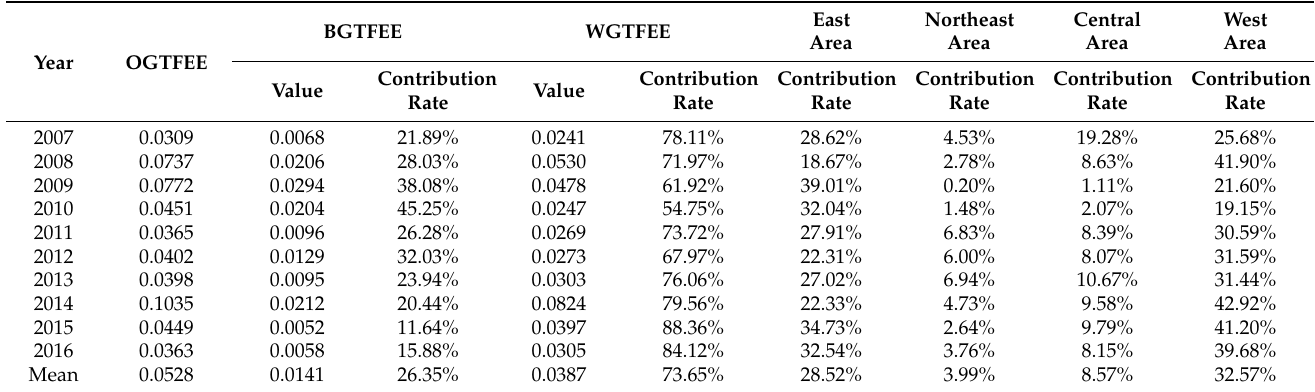
Table 3. The Theil index and its decomposition of TFEE in China’s mining